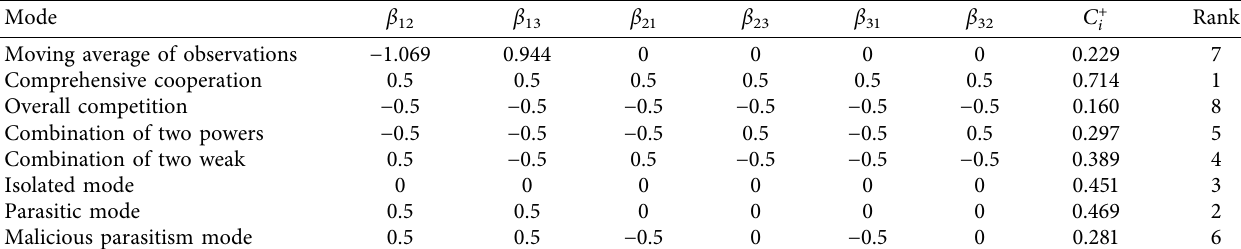
Table 9: Result of